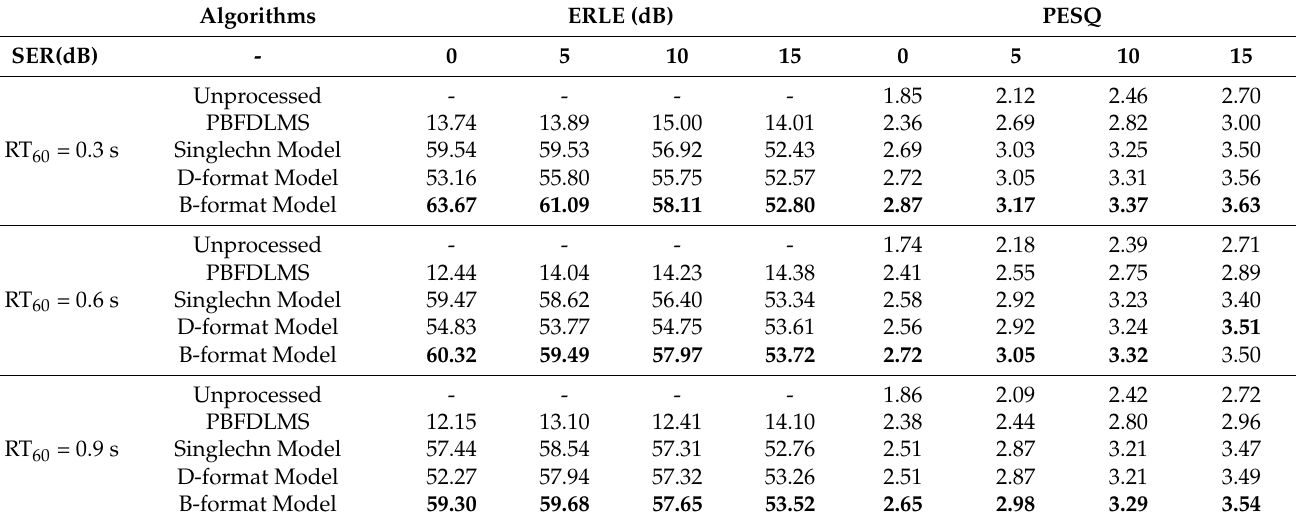
Table 3. As in Table 2 but for the nonstandard surround set-up